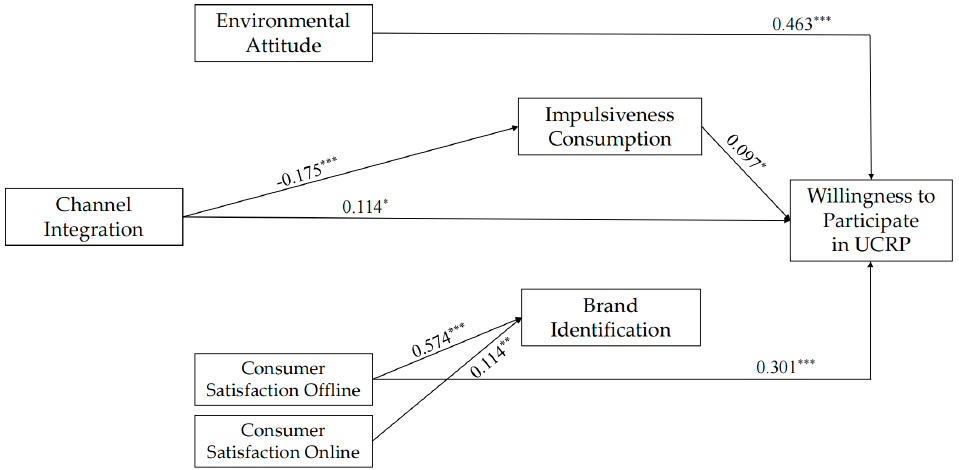
Figure 3. Final Measurement Model. Note: *** p < 0.01, ** p < 0.05, * p < 0.1.